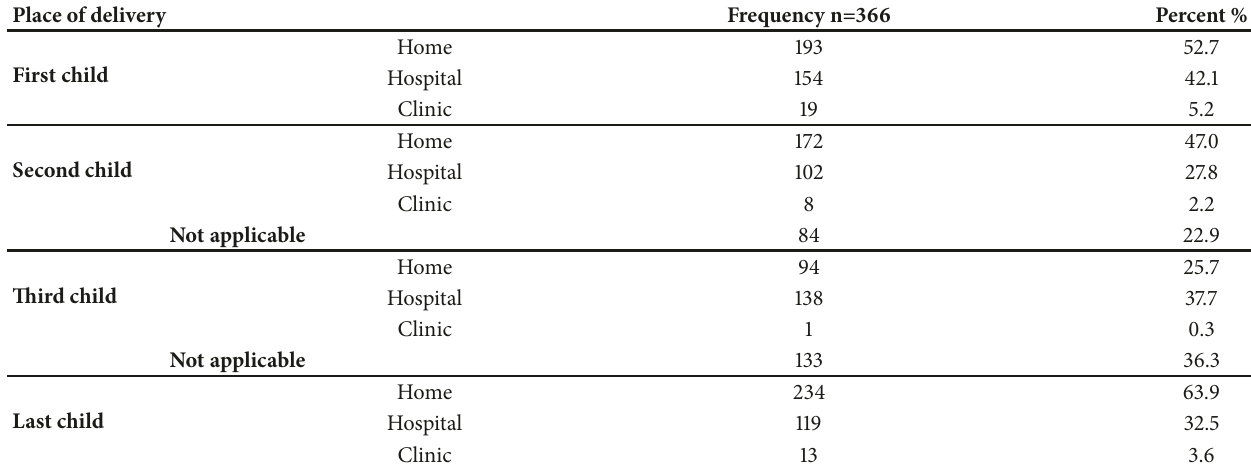
Table 3: Place of delivery